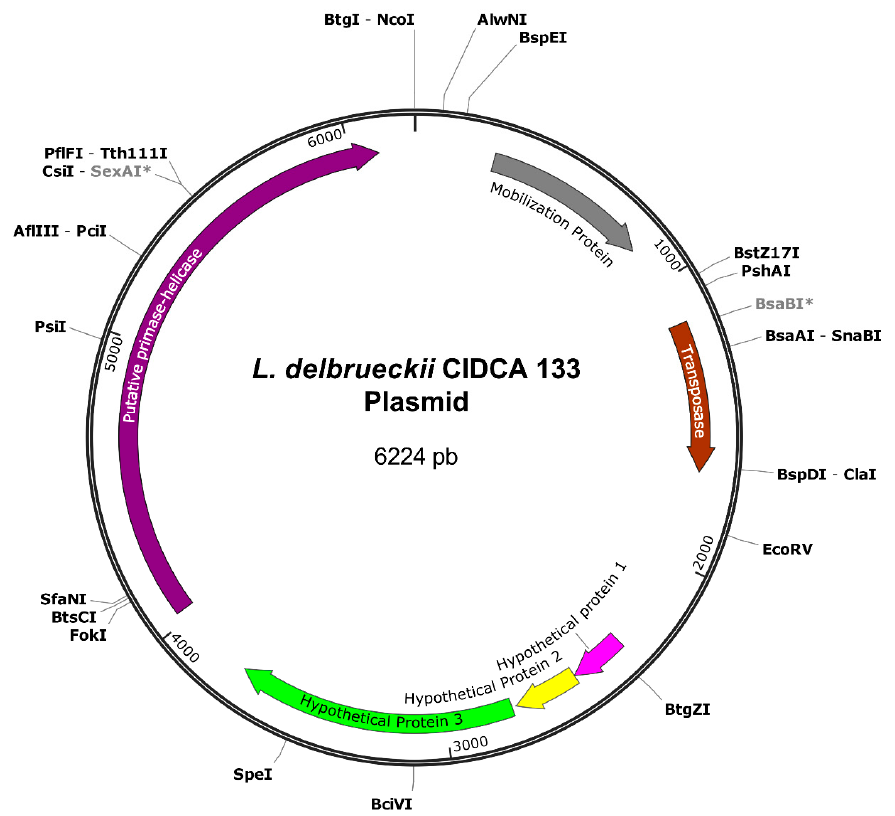
Figure 1. Schematic representation of the plasmid circular map present in Lactobacillus delbrueckii CIDCA 133 and restriction enzyme cut sites. Asterisk (*) indicates site blocked by methylation.